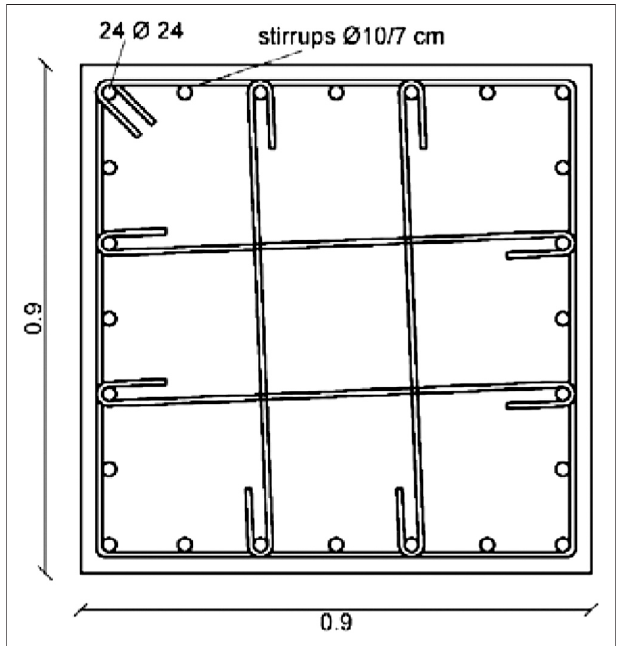
FIGURE 4 | Column cross-section.